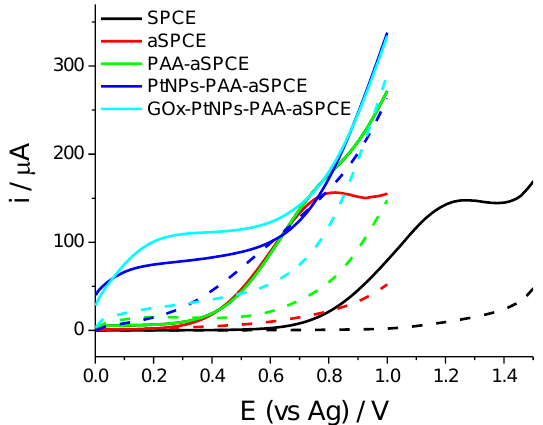
Figure 1. Anodic linear scan voltammetry (LSV) responses of the different electrode modification steps in the absence (dashed lines) and the presence of 5 mM of H 2 O 2 (solid lines). The measurements were performed in 0.1 M PB.